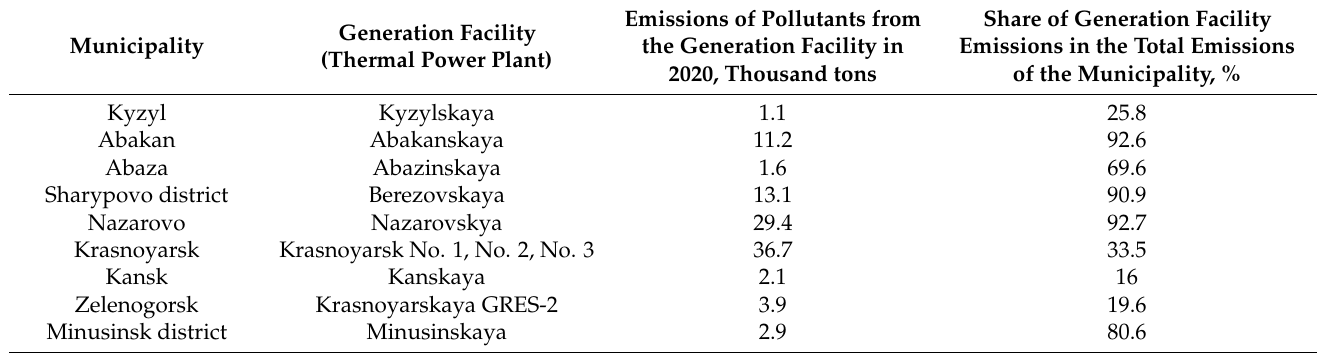
Table 4. Impact of large power generation facilities on atmospheric air quality in municipalities. Source: Government Reports on the State and Protection of the Environment, Siberian Generat- ing